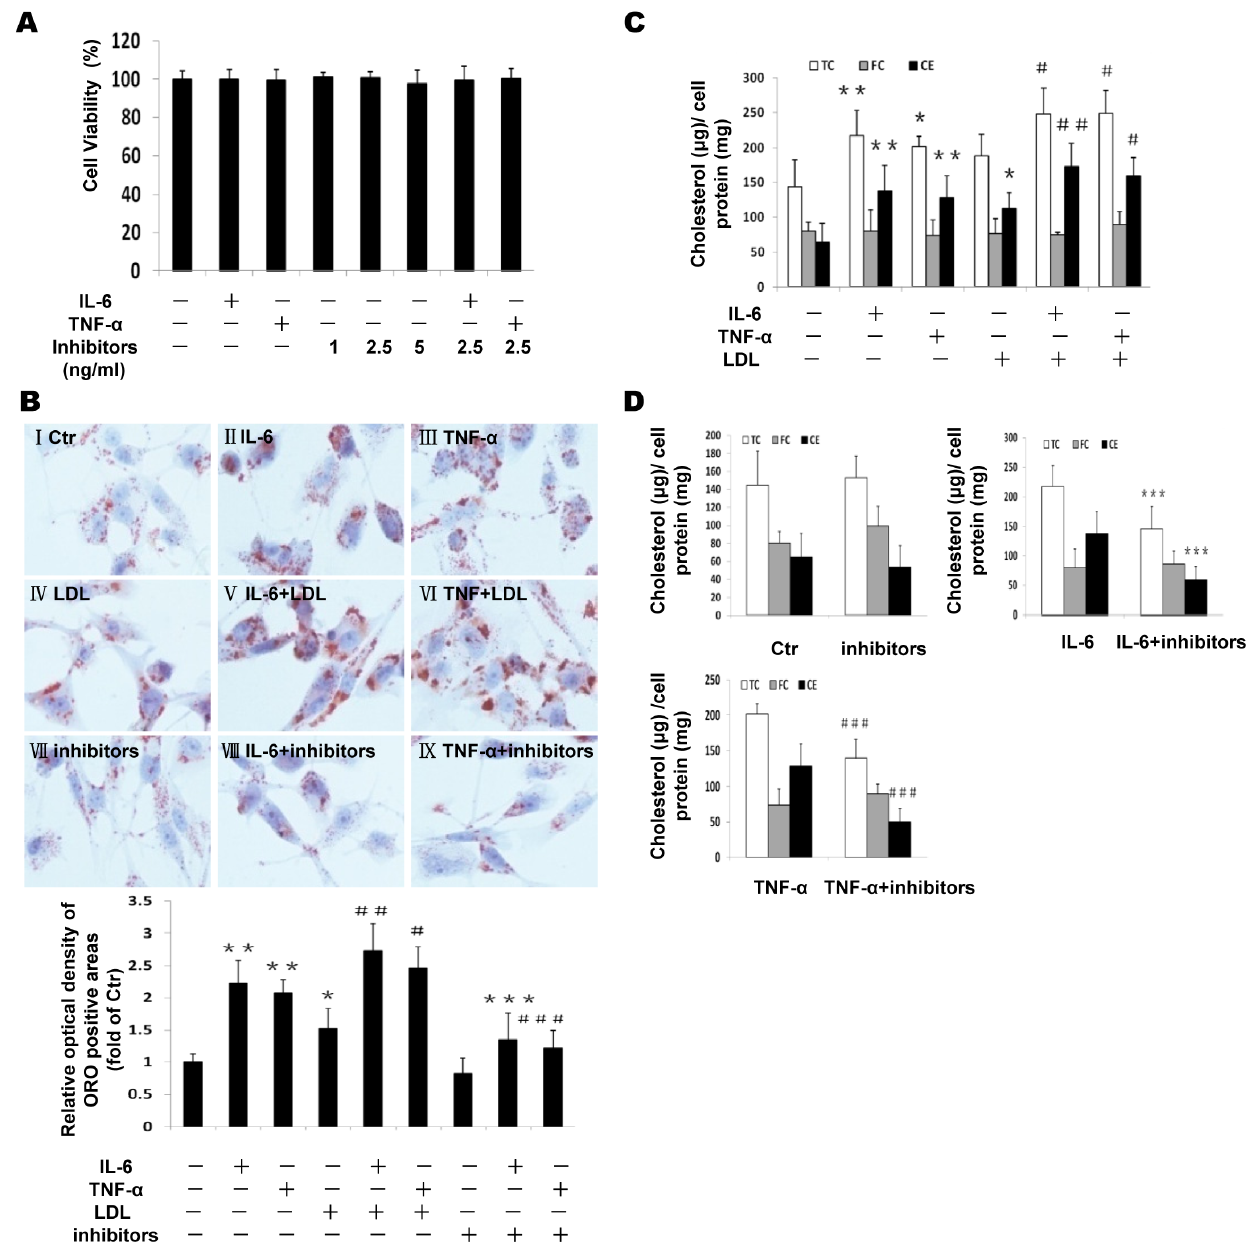
Figure 1. Effects of inflammation and Golgi glycosylation enzyme inhibitors on intracellular cholesterol accumulation in THP-1 macrophages. THP-1 macrophages were incubated in serum free medium for 24 h at 37 u C. The medium was then replaced by fresh serum-free medium in the absence (control) (I) or presence of 40 ng/ml IL-6 (II) or 50 ng/ml TNF- a (III) or 25 m g/ml LDL (IV) or 40 ng/ml IL-6 plus 25 m g/ml LDL(V) or 50 ng/ml TNF- a plus 25 m g/ml LDL (VI) or glycosylation inhibitors (VII), or 40 ng/ml IL-6 plus inhibitors (VIII), or 50 ng/ml TNF- a plus inhibitors (IX) for 24 h at 37 u C. Cell viability was determined using the MTT assay as described in Methods. Cell viability is expressed as the percentage of absorbance from treated cells compared to untreated cells. Graphs represent the average values (M 6 SD) of three independent experiments with triplicate biological measurements for each experiment (A). The cells were examined for lipid inclusions by Oil Red O (ORO) staining. The results are typical of those observed in four separate experiments ( 6 400). Semi-quantitative analysis of ORO positive staining was performed by the Image-J software. Results represent mean 6 SD from 4 separate fields (B). Intracellular free cholesterol and total cholesterol were assayed as described in the Materials and Methods section. Values are means 6 SD of duplicate wells from 4 experiments (C and D). * P , 0.05 vs control; ** P , 0.01 vs control; *** P , 0.01 vs IL-6; # P , 0.05 vs LDL; ## P , 0.01 vs LDL; ### P , 0.01 vs TNF- a . TNF- a upregulated both mRNA (Figure 2A) and protein (Figure 2B and 2C) expression of LDLr and HMGCoAR. In addition, we checked protein levels of N-SREBP2 in nucleus (the We investigated effects of inflammatory cytokines on the active format of SREBP2 for LDLr and HMGCoAR transcrip- expression of LDLr, HMGCoAR and SREBP2. Either IL-6 or